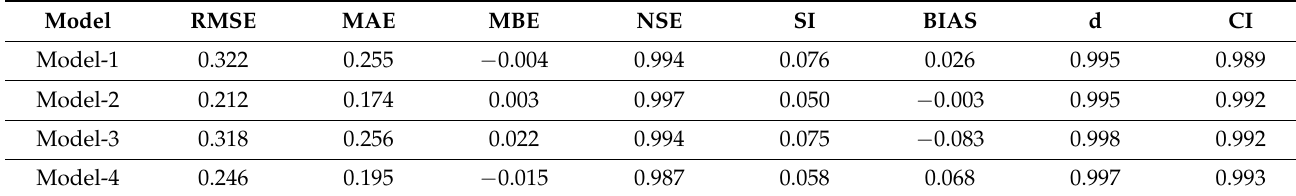
Table 6. Statistical indicators values using MLPNN method during testing period.